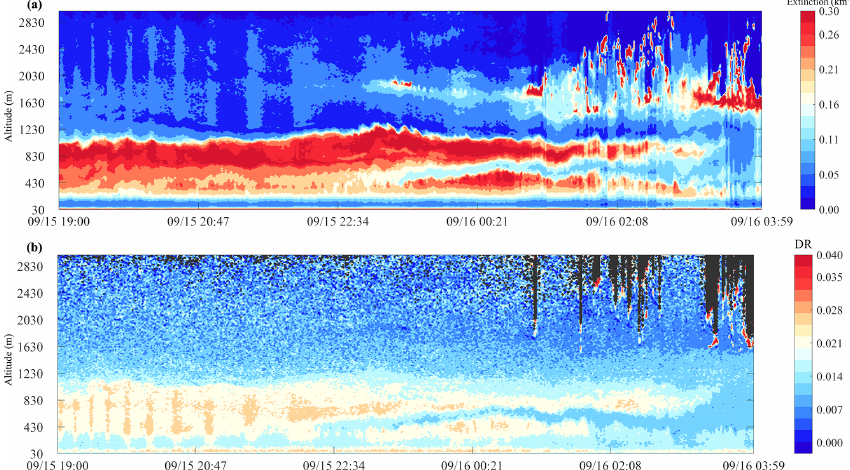
Figure 12. Extinction coefficient (a) and depolarization ratio (b) at 532nm from 19:00LT on 15 September 2019 to 03:59LT on 16 Septem- ber 2019.